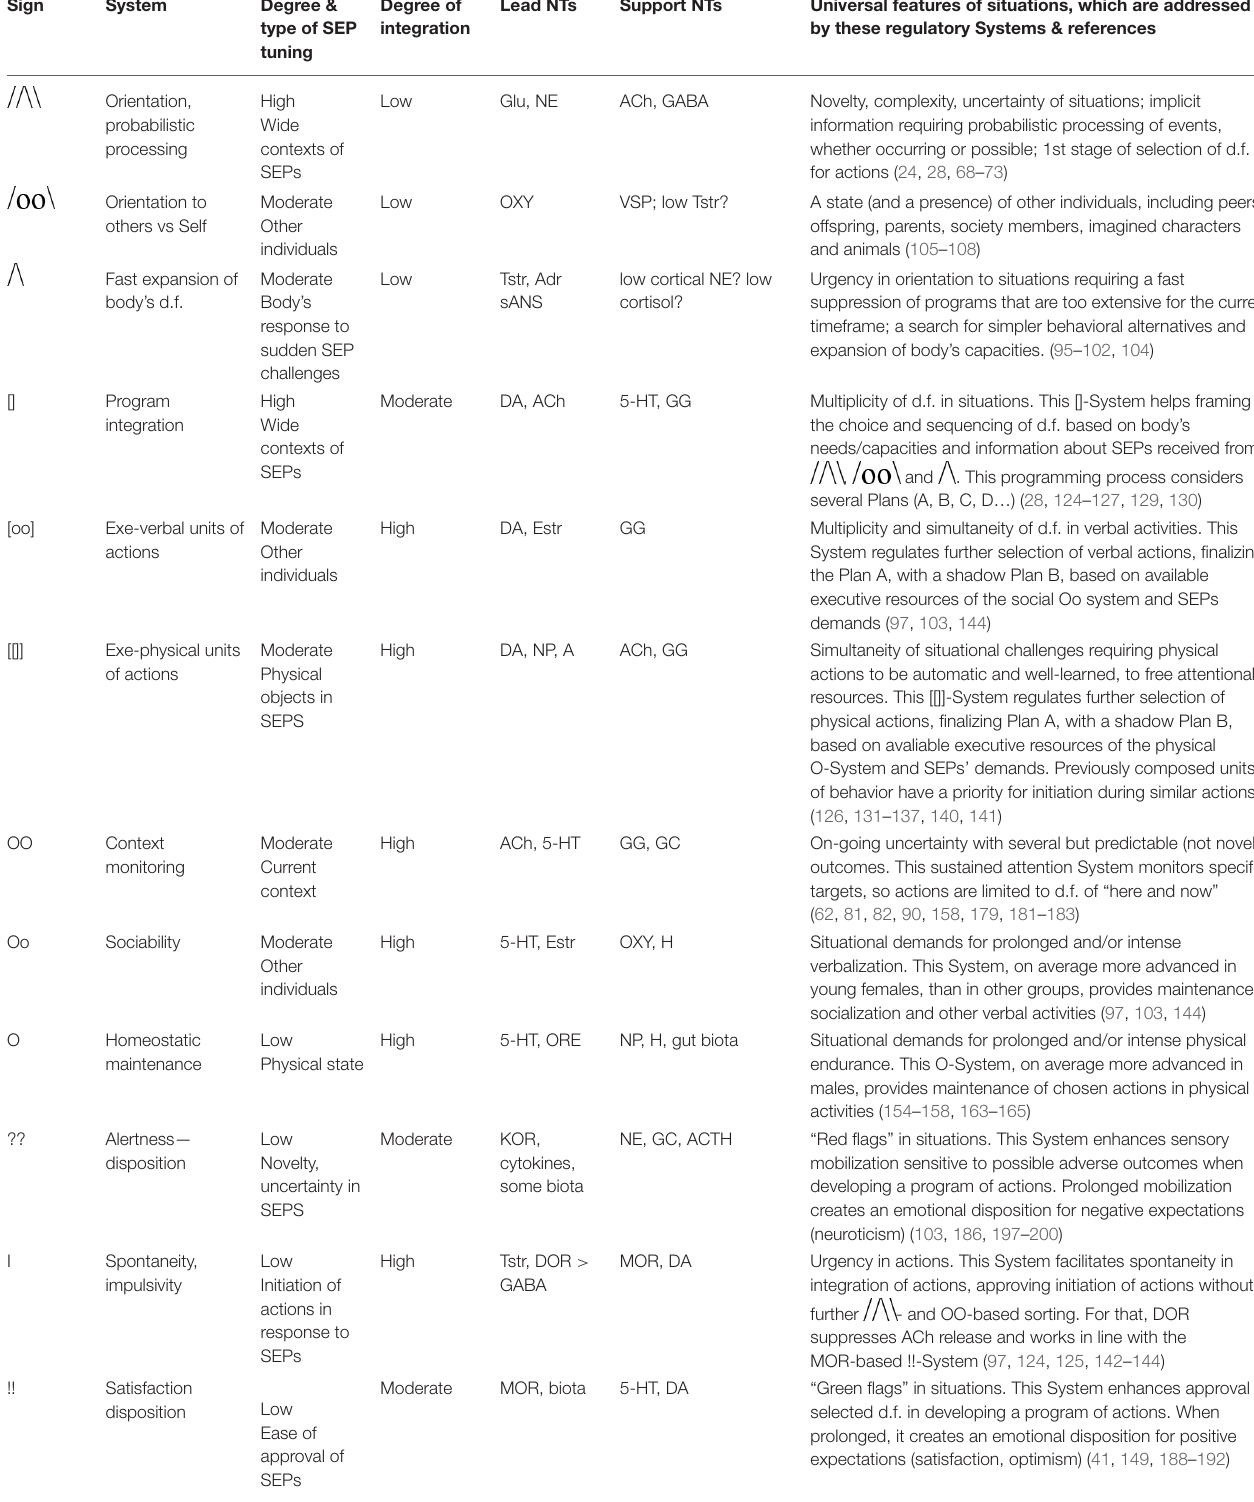
TABLE 1 | The neurochemical regulatory Systems, with their notations and contribution to the development of the program (choice) of actions. Sign System Support